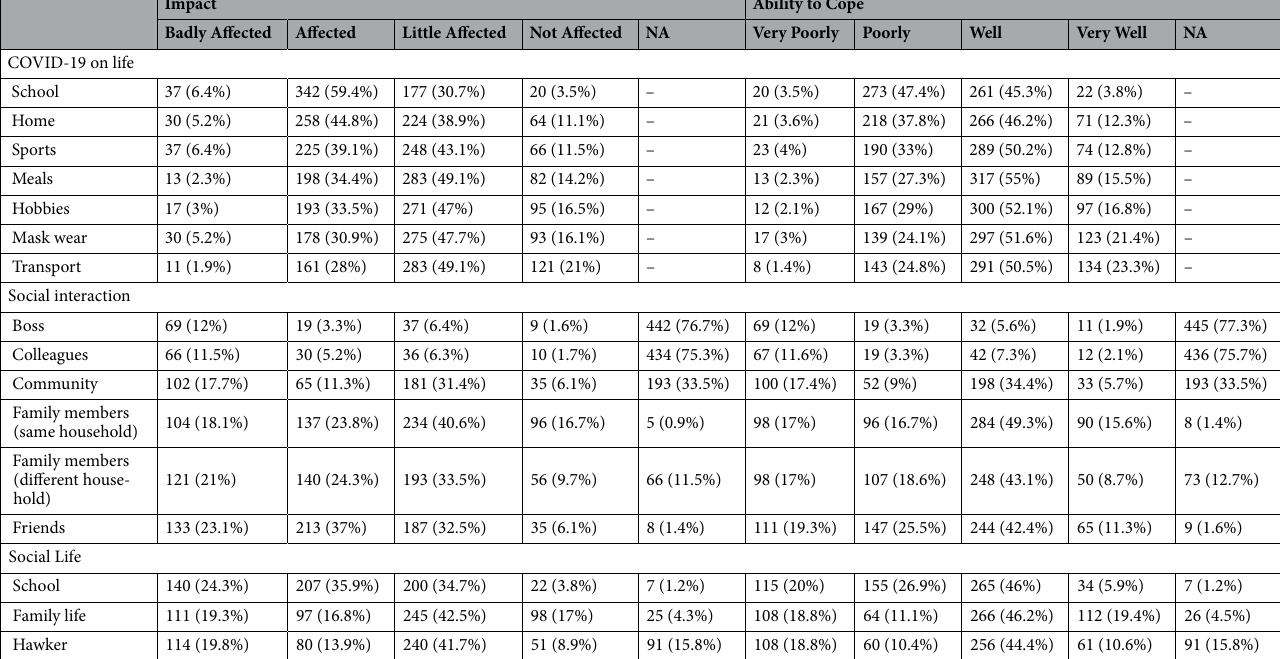
Table 2. Extent of impact and ability to cope in various life settings.